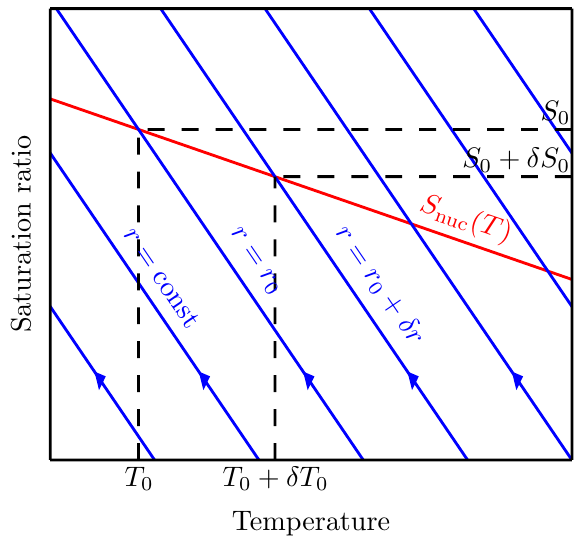
Figure 3. Diagram illustrating the initial conditions of the air parcels. Prior to nucleation air parcels follow isolines of water vapour mixing ratio r (shown here in blue) and approach the curve S nuc (T ) from below (as indicated by the arrows). Nucleation begins at the intersections of the r isolines with the curve S nuc (T ) .